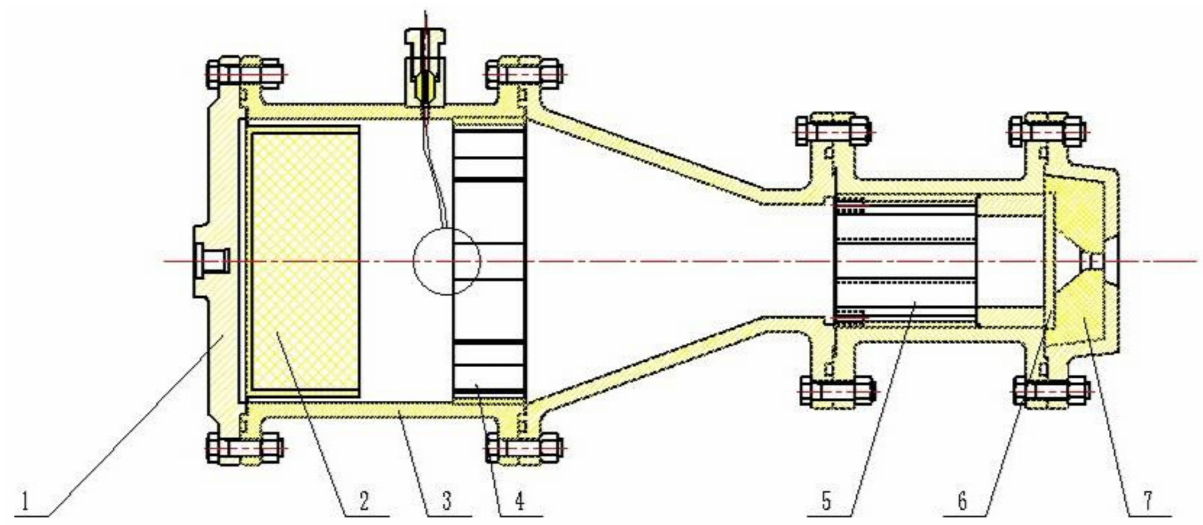
Figure 7. Structural chart of the experiment device.